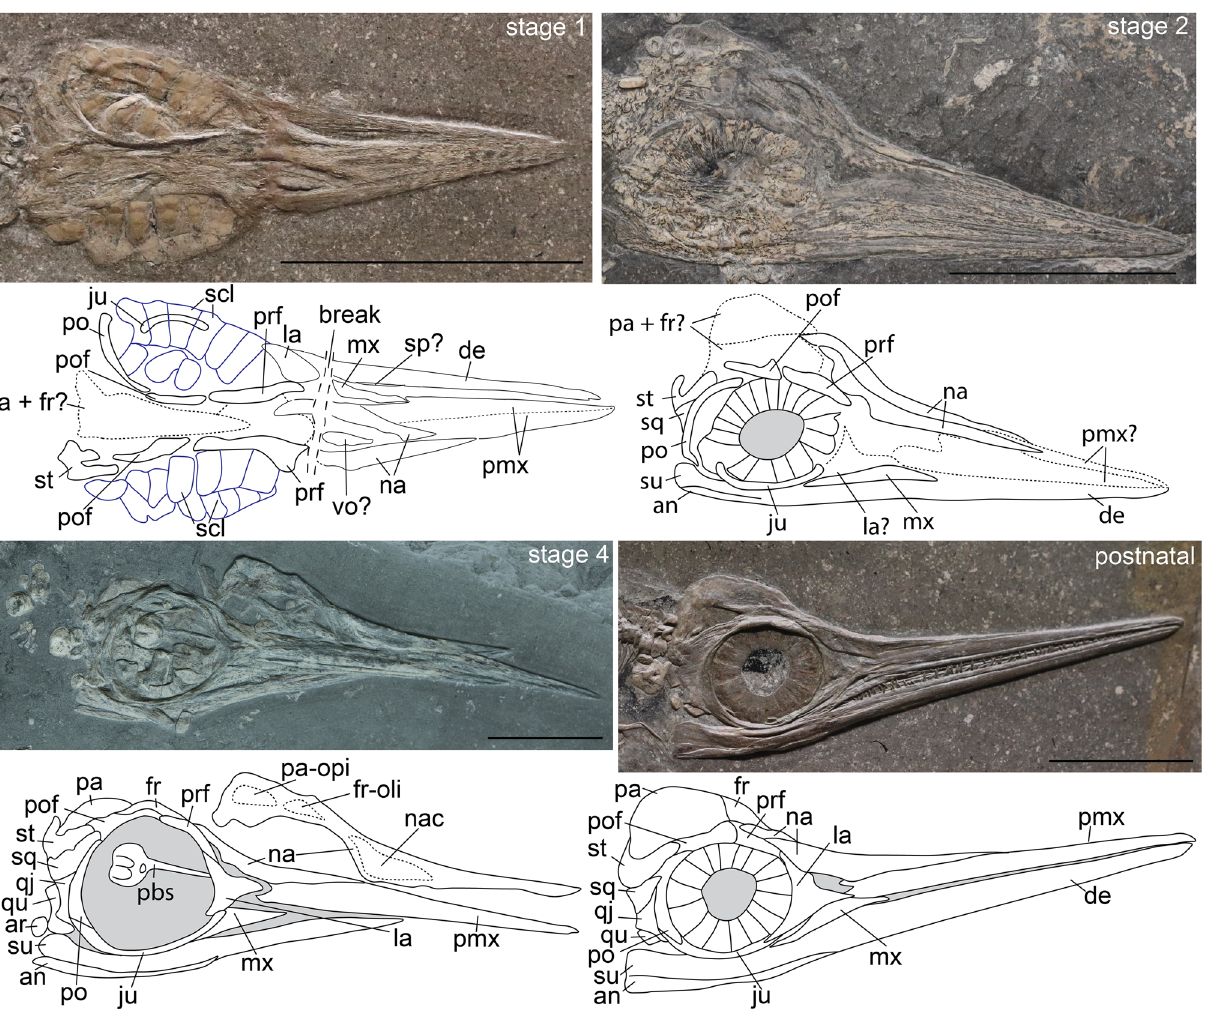
Figure 1. Proposed prenatal stages and earliest postnatal developmental stage of Stenopterygius quadriscissus on the basis of cranial ossification of single elements and suture closure. Stage 3 is subdivided into 3a and 3b on the basis of ossification of isolated elements and only represented by disarticulated material. Stage 1, SMNS 10460; Stage 2, SMNS 50963; Stage 4, SMNS 54064; Postnatal 1, SMNS 12821. an angular, ar articular, de dentary, fr frontal, fr-oli frontal olfactory lobe indentation, ju jugal, la lacrimal, mx maxilla, na nasal, nac nasal capsule, pa parietal, pa-opi parietal optic lobe indentation, pmx premaxilla, po postorbital, pof postfrontal, prf prefrontal, qj quadratojugal, qu quadrate, scl sclerotic plate, sp splenial, sq squamosal, st supratemporal, su surangular, vo vomer. Scale bar (all parts) = 50